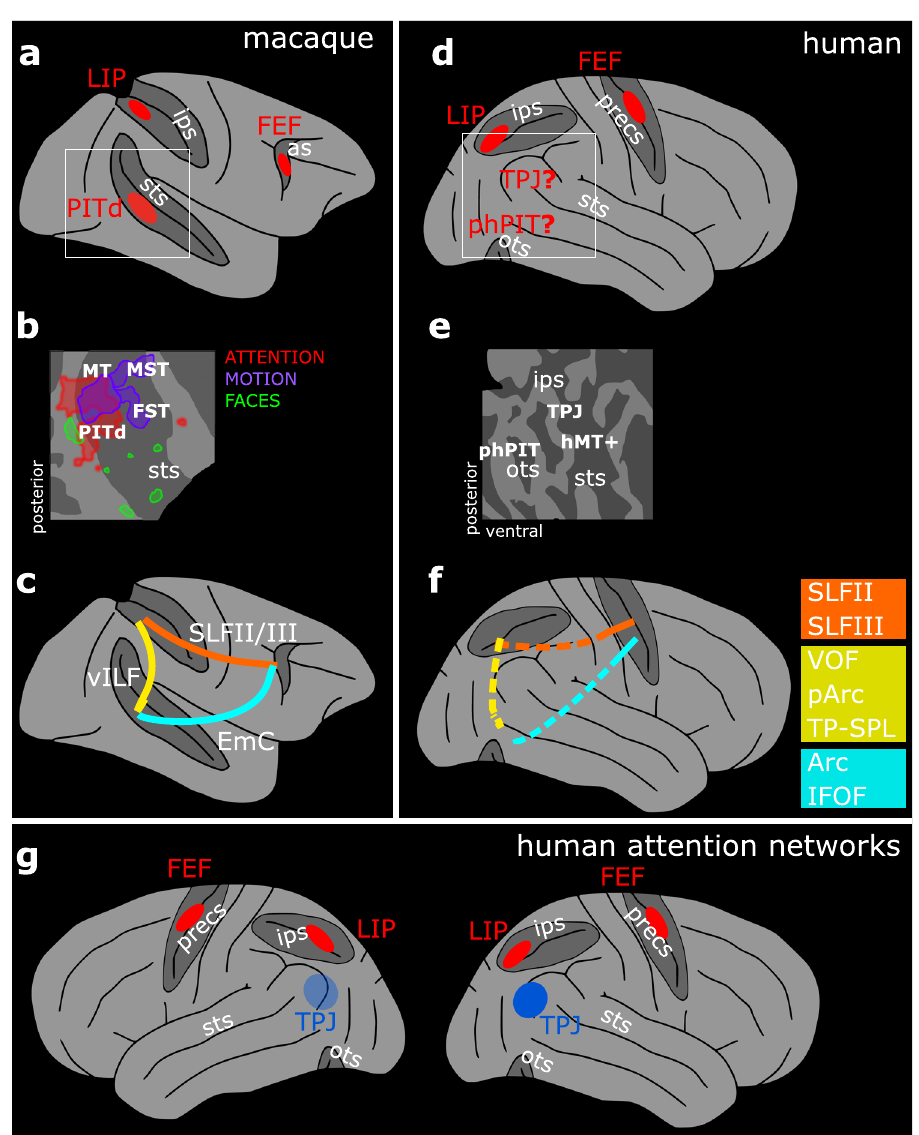
Fig. 1 Functional and structural identi fi cation of the putative ventral endogenous attention node. a Whole brain model of the three-node attention network of the macaque as de fi ned by functional activation in ref. 10 . b Functional characterization of the macaque ventral attention node and nearby areas displayed on a schematic fl at map of the right superior temporal sulcus 10 . PITd was activated by attention, but not by motion – the task relevant dimension. c Schematic of macaque PITd connections with the dorsal attention network as de fi ned in ref. 19 . d Whole brain model of the human fronto-parietal attention network and the two candidate areas possibly constituting a human ventral node for endogenous attention. e Schematic fl at map of the human superior temporal sulcus and the quest for a functional characterization of parieto-temporal areas around phPIT and TPJ. f Schematic of the hypothesized connections between the putative ventral attention node and the dorsal attention network; colored squares indicate possible alternative hypothesis for the homolog fi bers bundles in humans and macaques. g Schematic of the components of the endogenous (red) and exogenous (blue) attention network in the human brain; neuroimaging data suggest stronger activation in the right hemisphere for the latter (opaque vs. transparent blue). as arcuate sulcus, ips intraparietal sulcus, ots occipito-temporal sulcus, precs pre-central sulcus, sts superior temporal sulcus, FEF Frontal Eye Field, FST fundus of the superior temporal sulcus, LIP Lateral Intraparietal area, MT and MT + middle temporal area, MST medial superior temporal area, PITd Posterior Infero-Temporal dorsal area, phPIT putative human Posterior Infero-Temporal area, TPJ temporo-parietal junction, Arc Arcuate Fasciculus, EmC Extreme Capsule, IFOF Inferior Frontal Occipital Fasciculus, ILF Inferior Longitudinal Fasciculus, pArc posterior Arcuate Fasciculus, SLF Superior Longitudinal Fasciculus, TP – SPL Temporo-Parietal connection to the Superior Temporal Lobule, vILF vertical branch of the Inferior Longitudinal Fasciculus, VOF Vertical Occipital